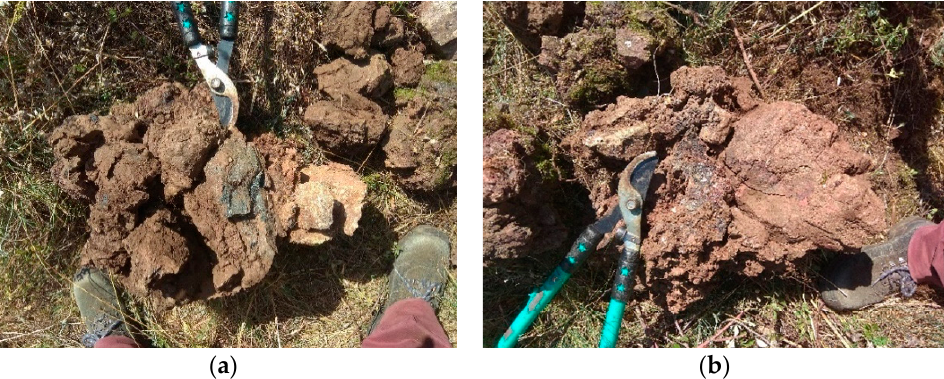
Figure 1. The samples studied were collected along the northern and north-west border of Serravuda top hill, Acri (Cosenza, Italy). Cemented blocks collected at the NW flanks of the Serravuda hill labelled SV 1 ( a ) and cemented blocks collected at the NW flanks of the Serravuda hill labelled C ( b ).